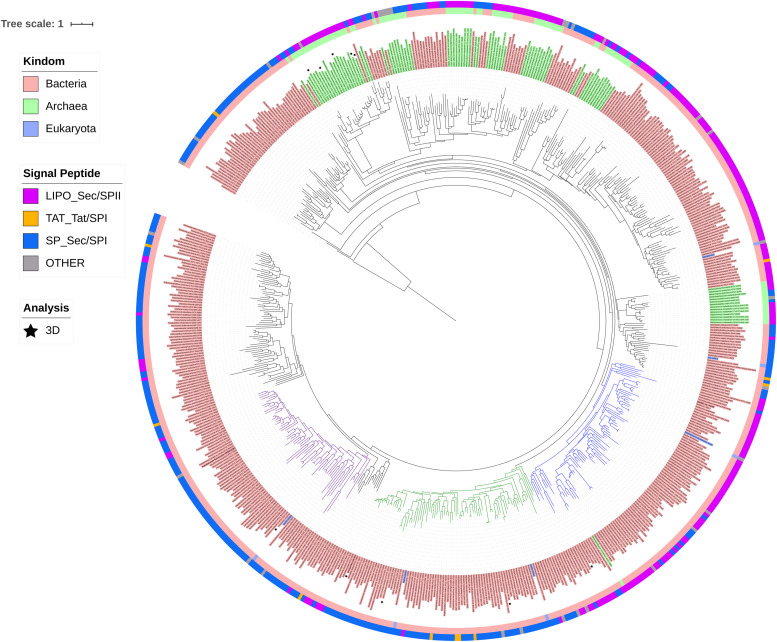
Phylogenetic analysis of ModA. Rooted phylogenetic tree of ModA and WtpA from Bacteria (pink, inner circle), Archaea (green, inner circle), and Eukaryota (blue, inner circle). Outer circle indicates different signal peptide type (LIPO_Sec/SPII in purple, TAT-Tat/SPI in yellow, SP_Sec/SPI in blue and other in gray). ModA proteins with PDB 3D structure data were indicated as black stars. Clades where XG196 ModA (blue clade), N2E2 ModA (purple clade), and E. coli ModA (green clade) belong to were also labeled in different colors.